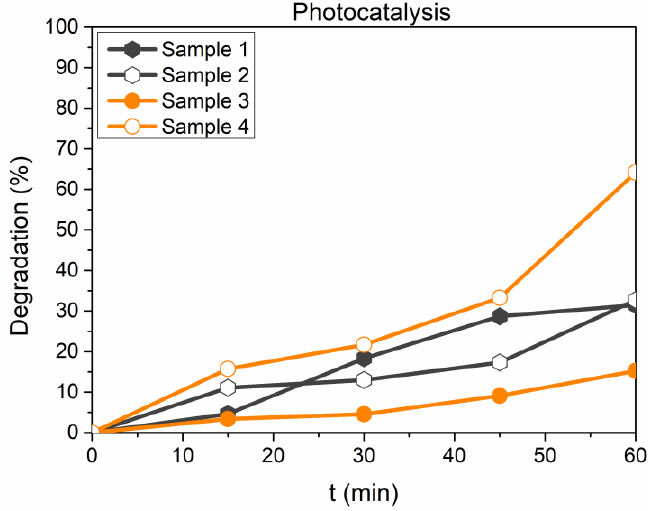
Figure 7. MO percentage degradation (calculated according to Equation (1)) for investigated sam- ples.